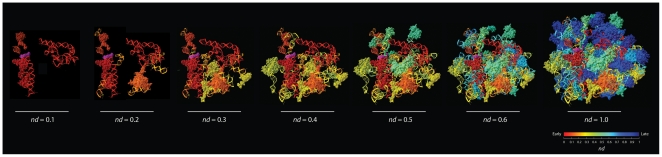
Model of ribosomal evolution.A chronological representation of the evolution of the ribosome shows that very early in ribosomal evolution (nd<0.3) rRNA helices interacted with r-proteins to form a processivity core that mediated nucleotide interactions, which later (nd = 0.3) served as center for coordinated and balanced RNP accretion leading to modern ribosomal function. The purple structure indicates extant mRNA, which is used as structural reference for location of primitive functional centers. We envision the primordial ribosome had replicative functions that likely involved RNA, so the mRNA molecule from the crystallographic model should be regarded as placeholder for the ancient coding molecule. rRNA is rendered as ribbon representation, mRNA and proteins as rendered as space-filling representations.